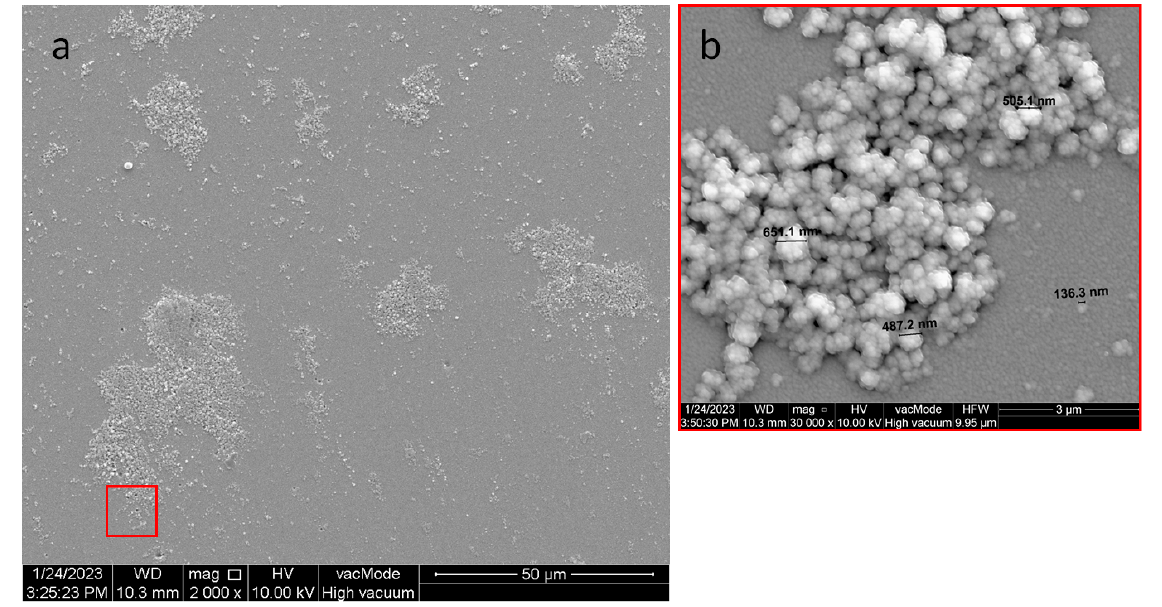
Figure 7. SEM images of the structure before annealing in 50 µm ( a ) and 3 µm ( b ) resolution.